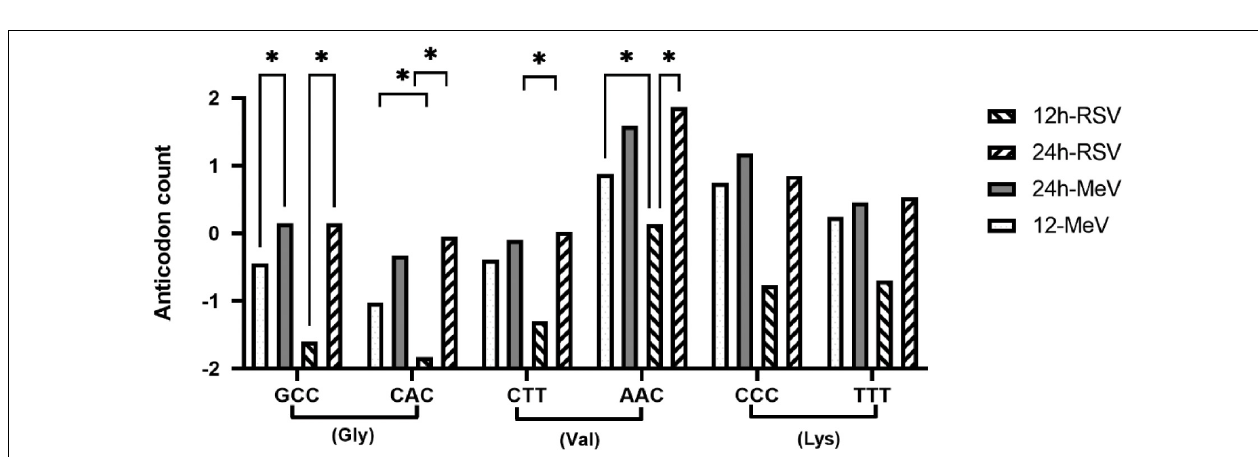
FIGURE 3 | RSV- and MeV -infection influence tRF expression in SHS cells. Total counts for the principal 5 (cid:48) tRFs in MeV- or RSV- infected SHS cells are shown. Error bars represent ± SD from three replicate data. Val, valine; Gly, glycine; Glu, glutamate; Lys, lysine; Asp, aspartate.